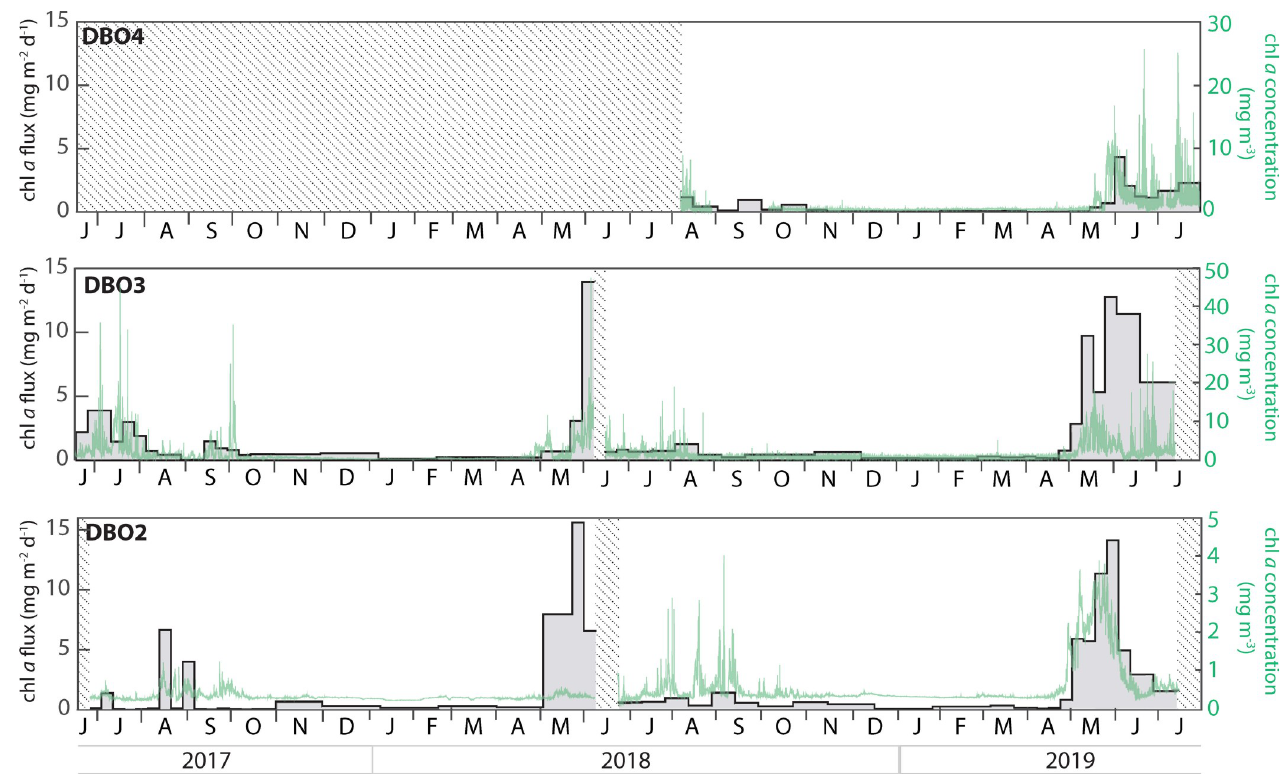
Fig 4. Chlorophyll a fluxes (grey bars) and suspended chlorophyll a concentration (green line) at each mooring site. Shaded areas represent periods without